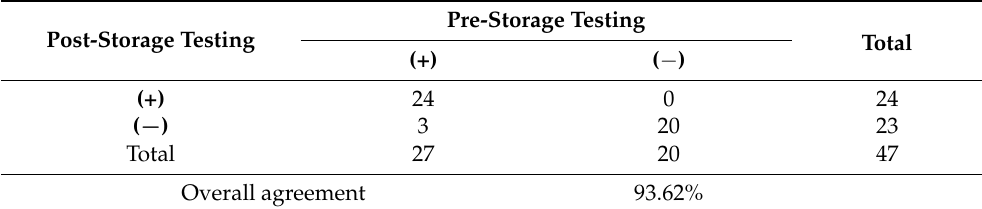
Table 1. Viability test of stored